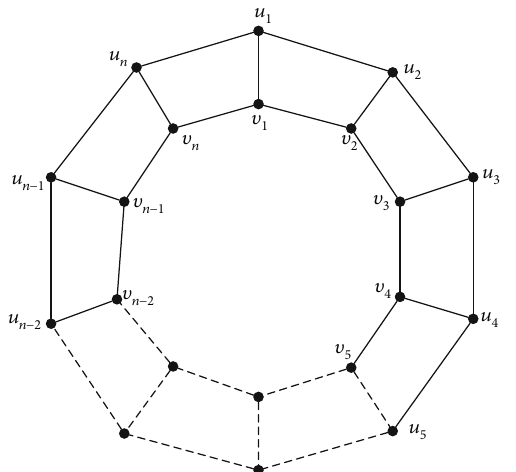
− graceful labeling and W 9,9 with edge 4